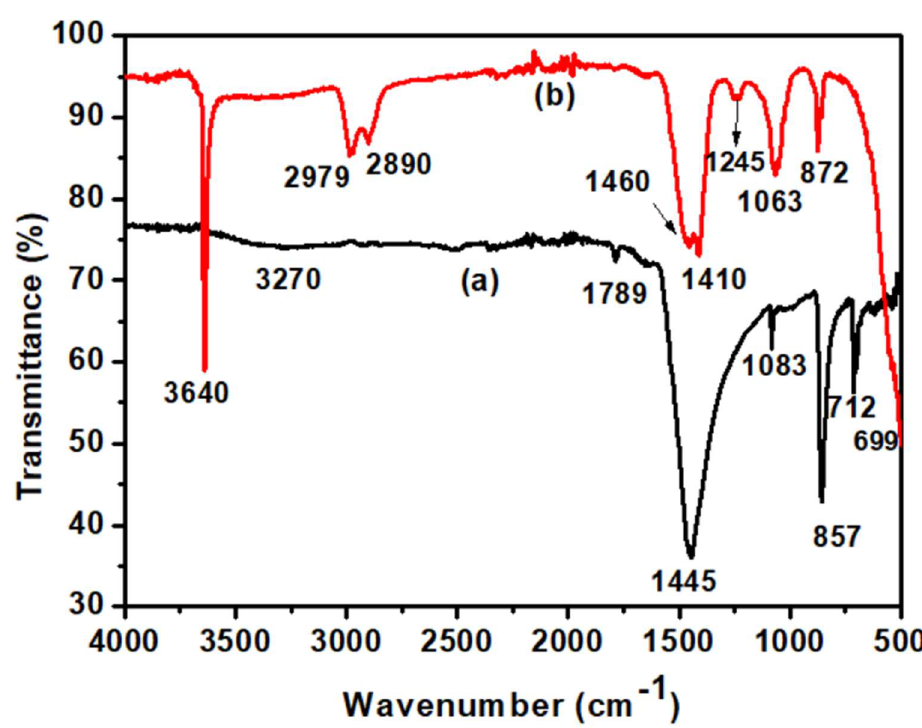
Figure 2. FT-IR curves for the ( a ) GRS shell and ( b ) calcined GRS shell at 900 °C.